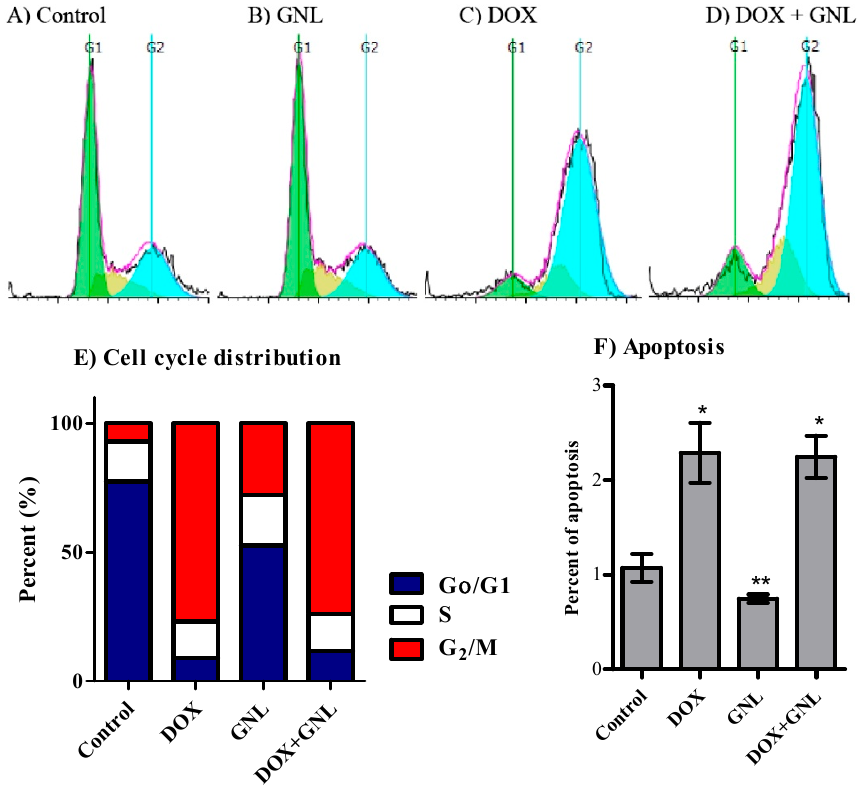
Figure 6. Effect of GNL on the cell cycle distribution of Huh-7 cells. The cells were exposed to GNL ( B ); DOX ( C ); or combination of GNL and DOX ( D ) for 24 h and compared to control cells ( A ); Cell cycle distribution was determined using DNA cytometry analysis and different cell phases were plotted ( E ) as percentage of total events; Sub-G cell population was taken as representative of late apoptosis/necrosis and was plotted as percent of total events ( F ). Data is presented as mean ± SD; n = 3. *: significantly different from control group; **: significantly different from DOX group.